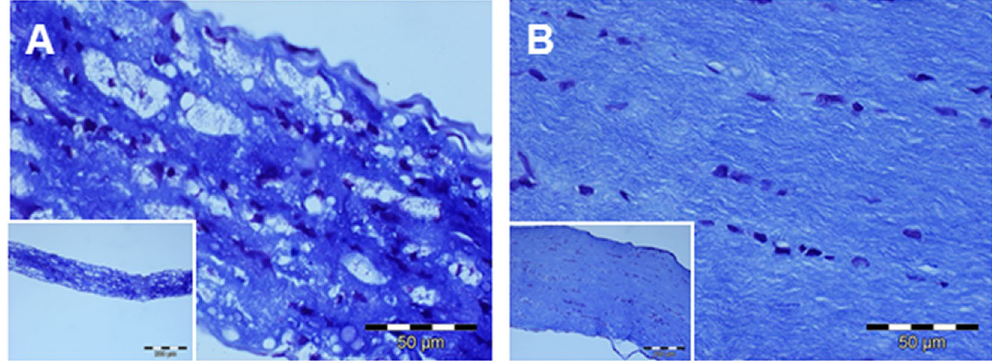
Figure 1. Histology of the intact and damaged optic nerve. In the photomicrographs provided in Fig. 1 illustrate the impact of severe ONC on the rat’s optic nerve: in contrast to a control nerve from a non-lesioned rat as shown in ( B ), a massively reduced diameter of the lesioned nerve can be recognized in ( A ) and a clearly damaged